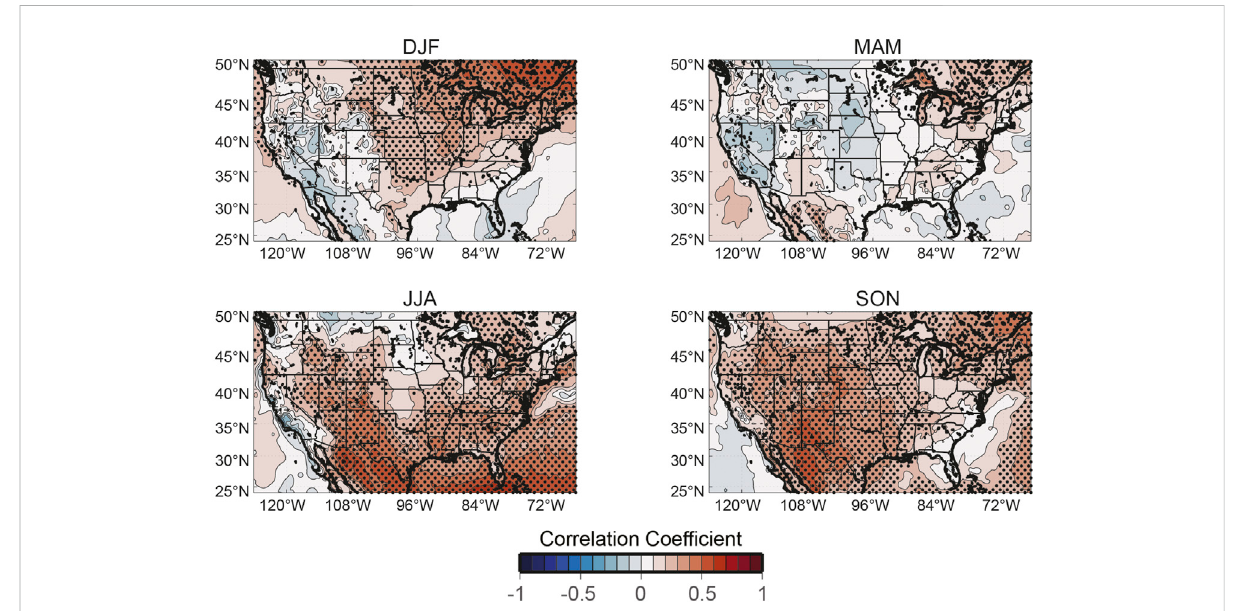
waters associated with the PDO produce positive precipitation anomalies (and vice versa) in the western and coastal SCUSA in all seasons and in the Gulf of Mexico in all seasons except autumn (Figure